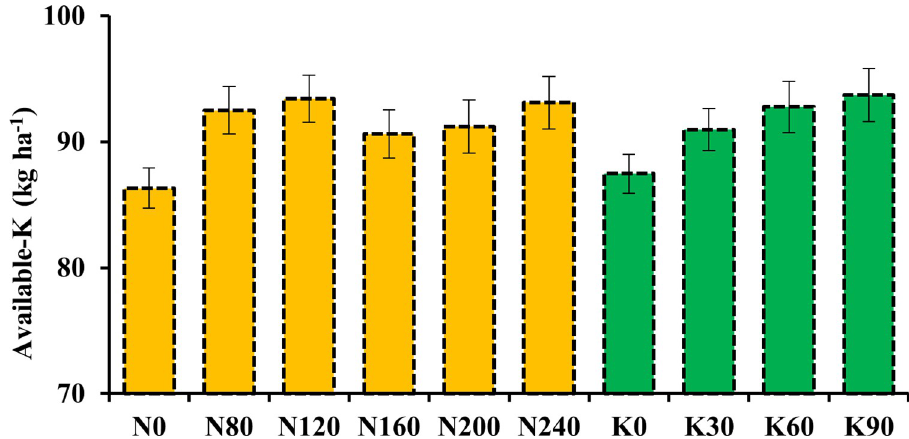
Fig 8. Effect of nitrogen (N) and potassium (K) application on available-K content in a sandy loam soil in sub- tropical India. Bars indicate the standard error from mean (S . E .